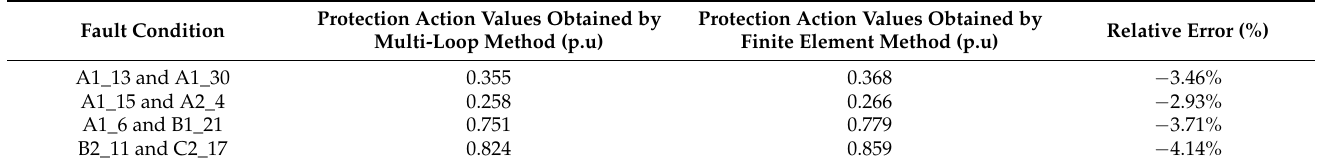
Table 4. Protection action values obtained by the multi ‐ loop method and finite element method under various faults.